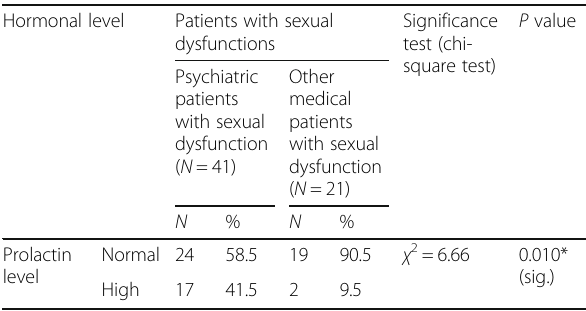
Table 15 Comparison of prolactin level among psychiatric patients with sexual dysfunctions and other medical patients with sexual